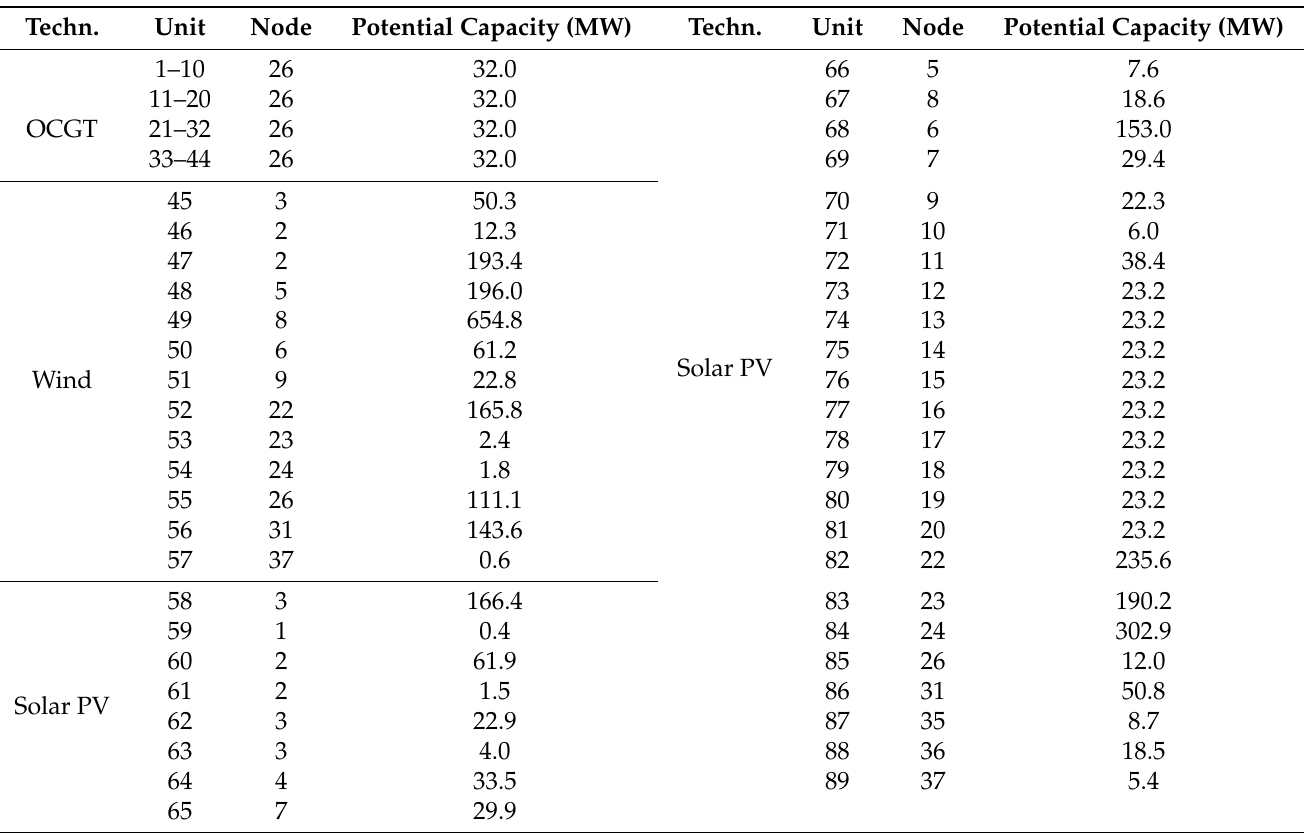
Table 2. Technical characteristics of candidate generating